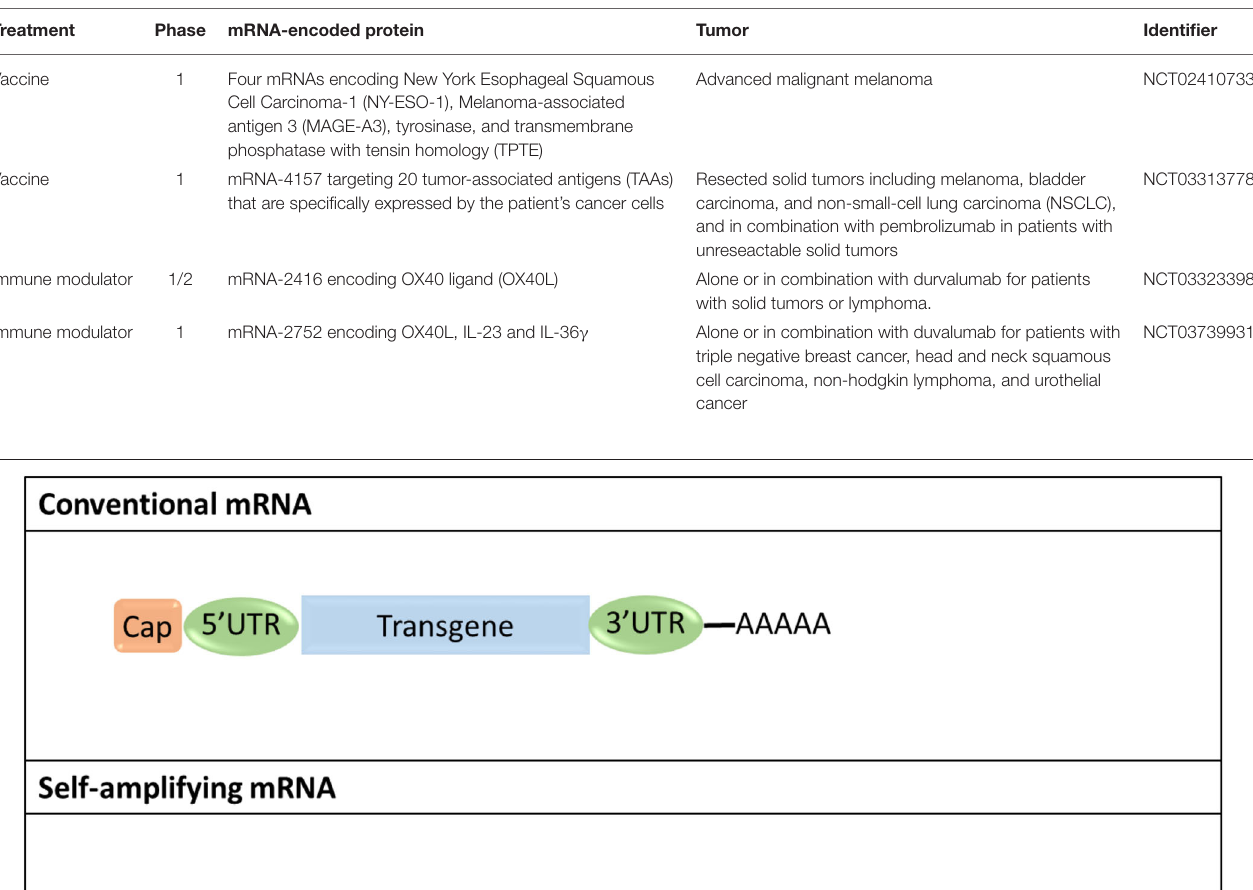
TABLE 1 | Clinical trials for formulated mRNA anti-cancer immunotherapies.